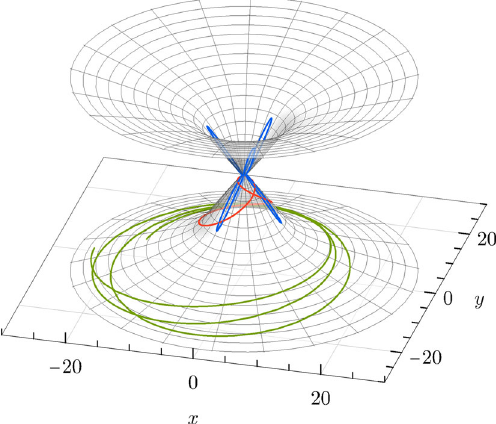
Fig. 37 Projection of orbits of massive particles in a wormhole space- time with equator and double throat